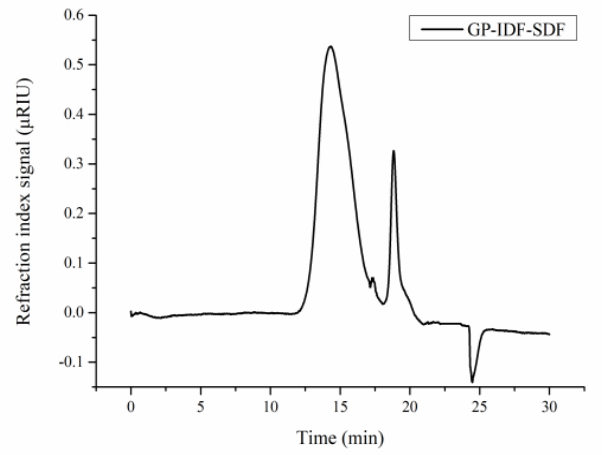
Figure 1. Gel permeation chromatogram profile of GP-IDF-SDF.